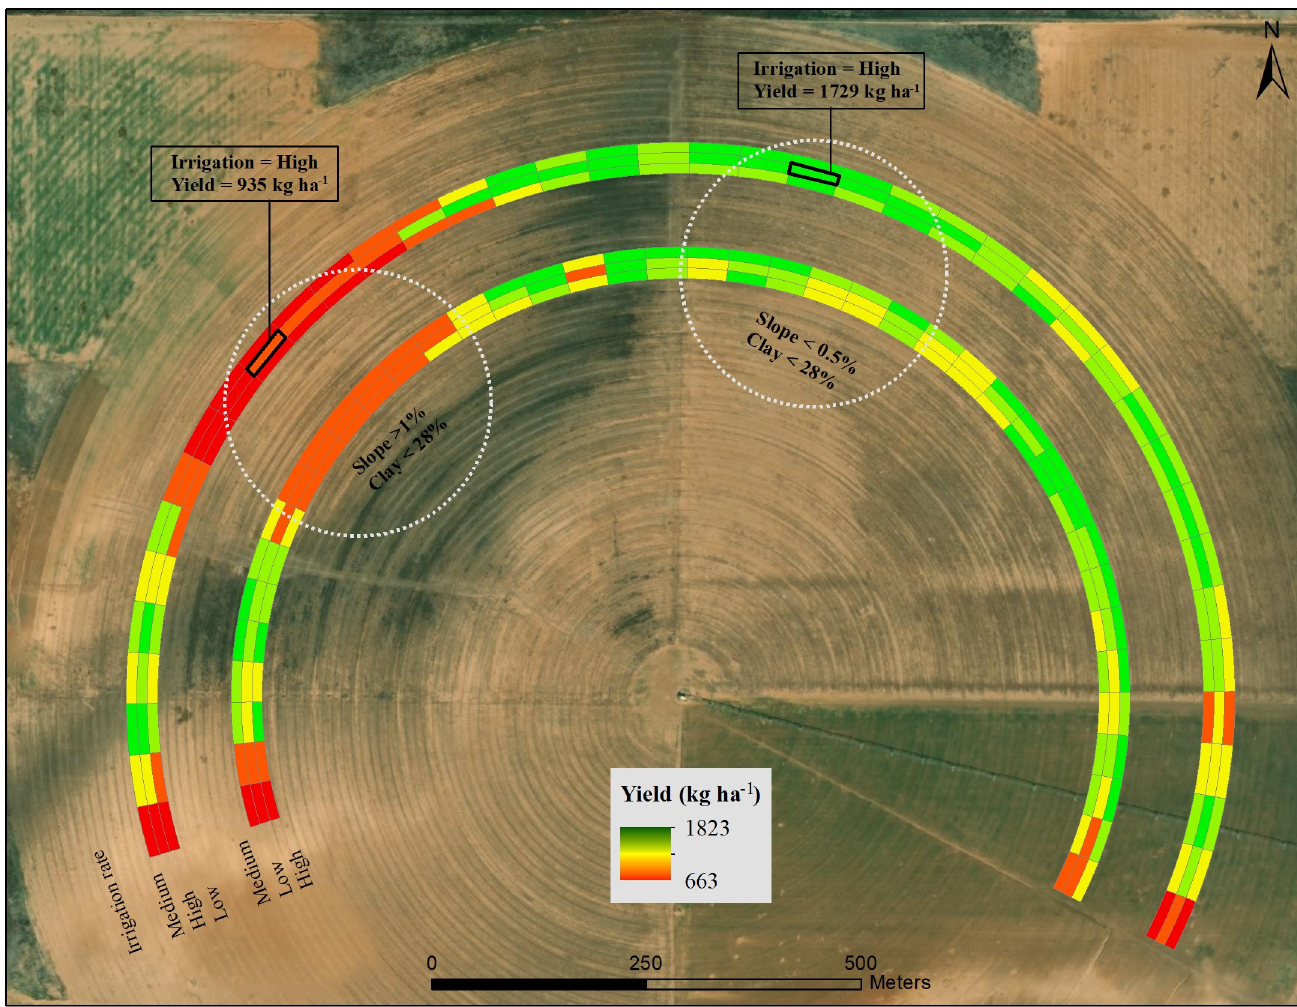
Fig 11. Cotton lint yield variability for three irrigation rates in a 122-ha field within a 194-ha farm at two areas with variable clay content (%) and slope (%) in Hale County, Texas in 2017. (Basemap source: Esri, DigitalGlobe, GeoEye, i-cubed, USDA FSA, USGS, AEX, Getmapping, Aerogrid, IGN, IGP, swisstopo, and the GIS User